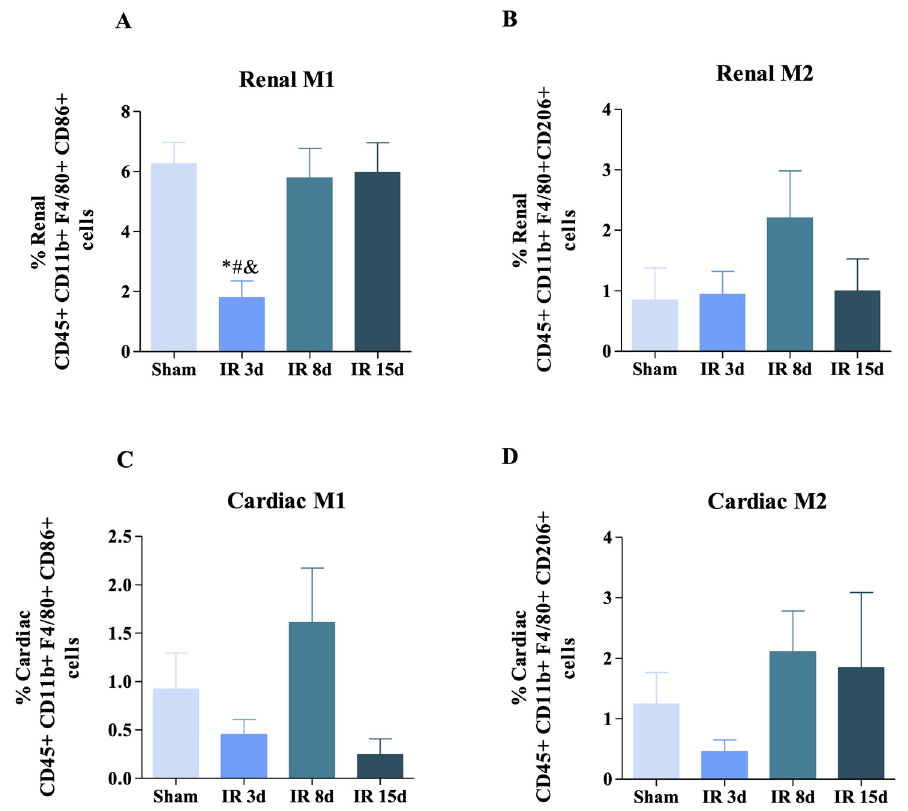
Figure 3. Renal ischemic injury induces macrophage populations in the renal and cardiac tissue. ( A )